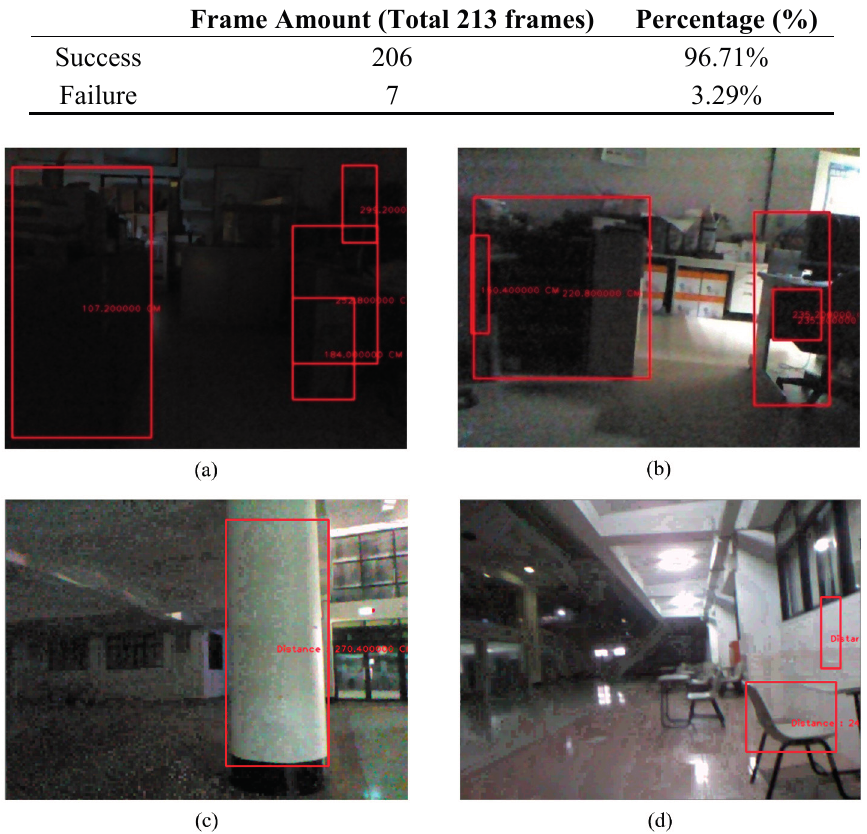
Table 2. The success rate and the failure rate for obstacle detection.